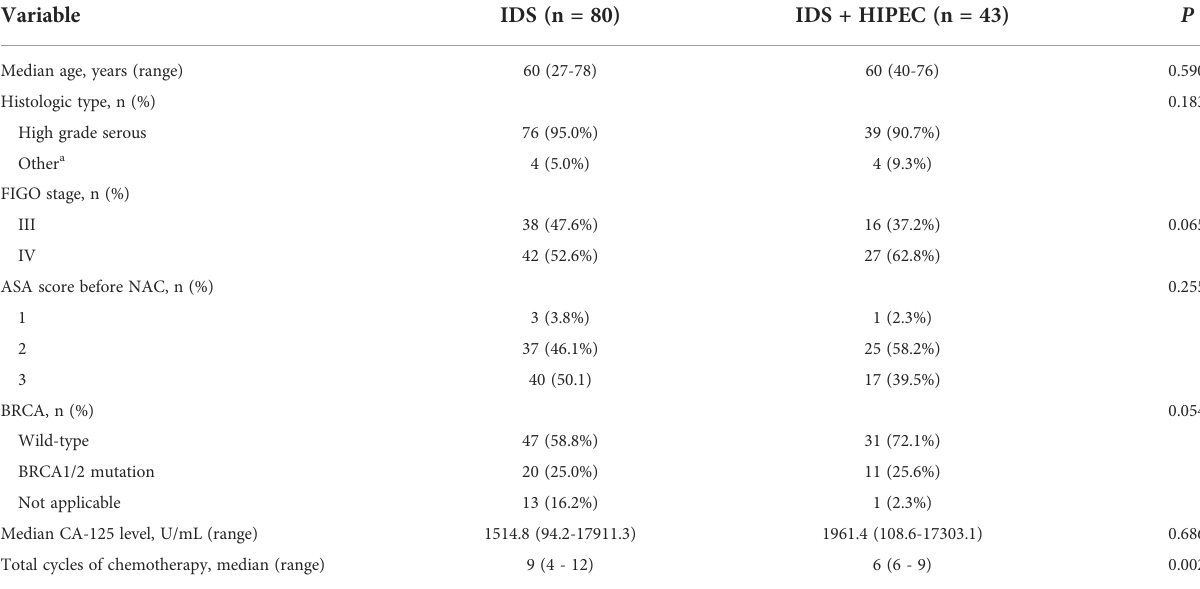
TABLE 1 Baseline patients ’